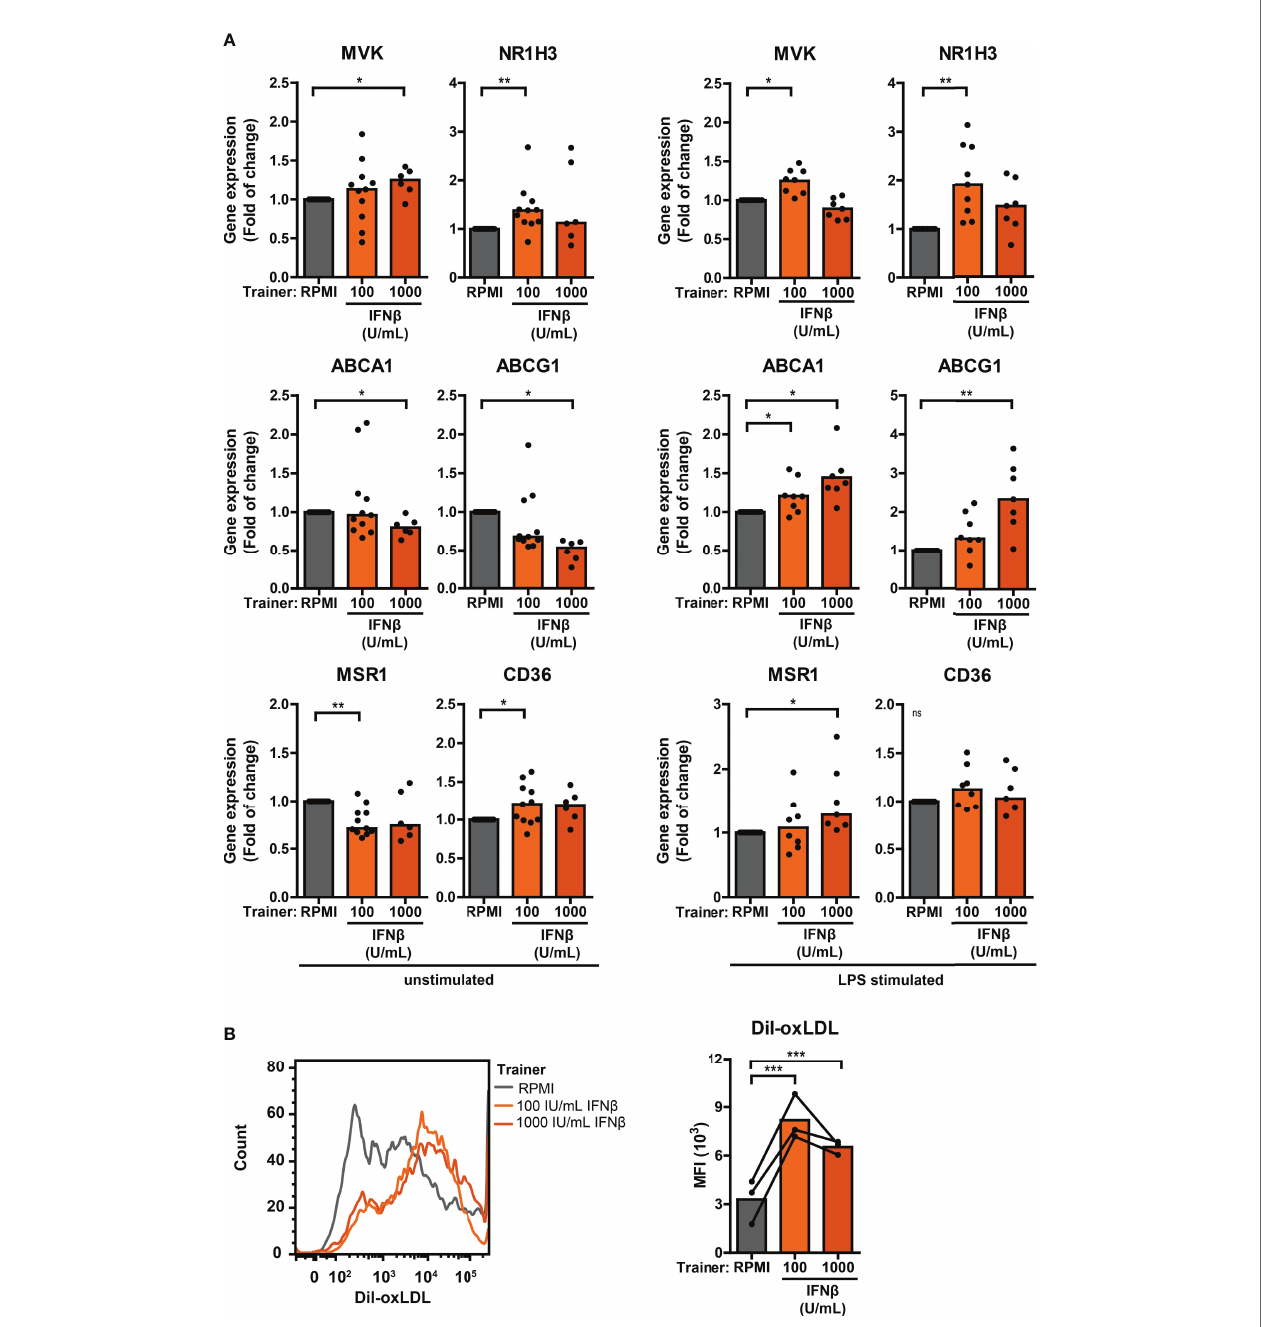
FIGURE 7 | Differential cholesterol metabolism in type I IFN-trained THP-1 cells. (A) Relative mRNA expression (2 DD CT ) of MVK , NR1H3 , ABCA1 , ABCG1 , MSR1 and CD36 in THP-1 cells trained with IFN b either before re-stimulation (left panel) or after 24 hour stimulation with 50 ng/mL LPS (right panel). Fold change expression was calculated relative to the corresponding untrained (RPMI) cells. (B) Representative histograms (left panel) and median fl uorescence intensity (MFI; right panel) of IFN b -trained THP-1 cells incubated with 50 µg/mL Dil-oxLDL for 4 hours. Depending on the data distribution, bars represent means or medians. One sample t-test or Wilxocon singed rank test were used to compare means/medians with a hypothetical 1 and repeated measures ANOVA was used to compare groups. ns: not signi fi cant, *p<0.05, **p<0.01,